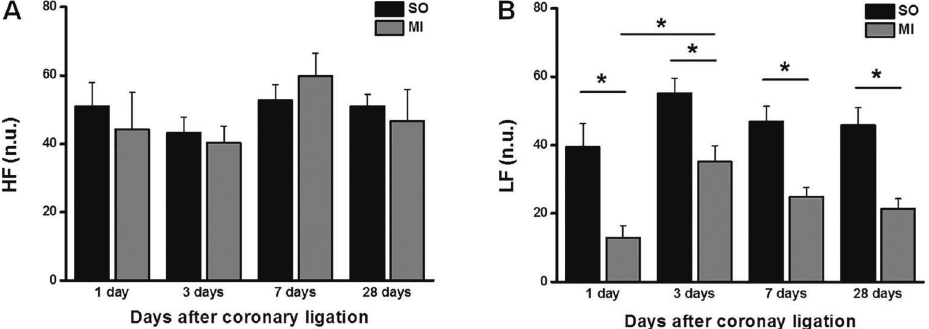
Figure 2. Spectral analysis of blood pressure variability. High frequency (HF) ( A ) and low frequency (LF) ( B ) components given in normalized units (n.u.) in sham-operated (SO) and infarcted (MI) rats studied at different times after surgery. Results are reported as means ± SE. *P o 0.05; data were compared by a two-way ANOVA and multiple comparisons were performed by Fisher ’ s post hoc